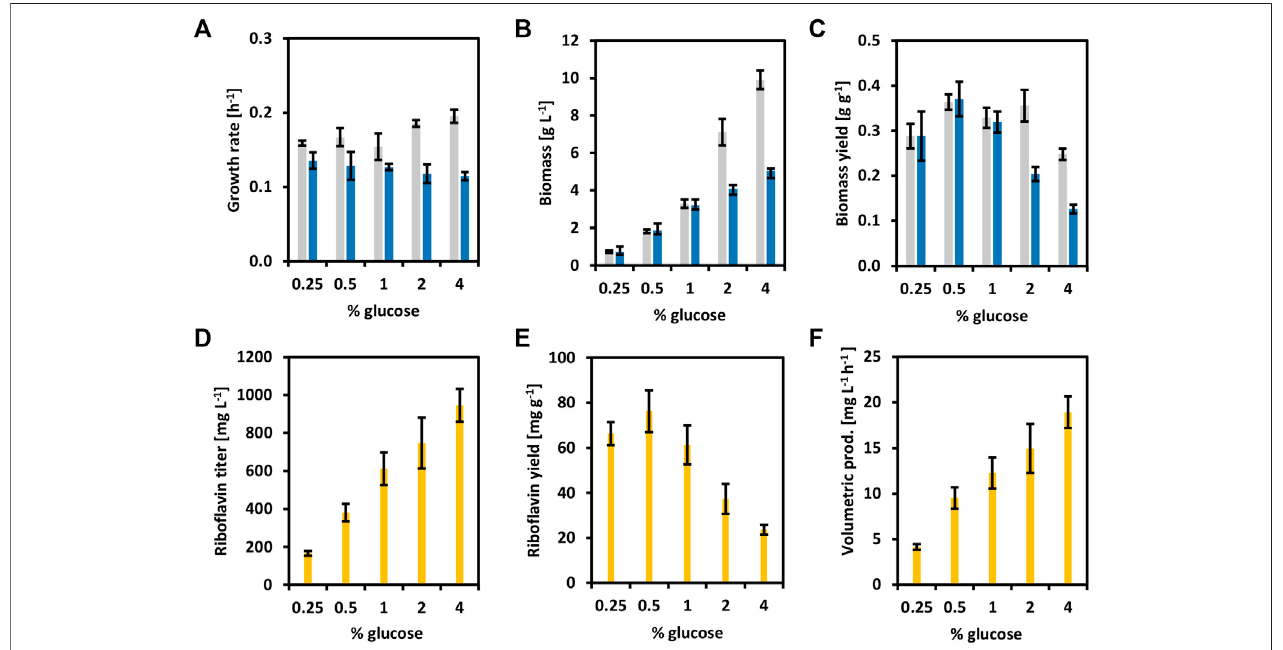
FIGURE 5 | Growth and ribo fl avin production from glucose of the strains CgRibo1 and CgRibo2. Concentrations of glucose ranged from 0.25 to 4 g L − 1 were tested.Growthrates(h − 1 ) (A) , fi nalbiomassesformed(gL − 1 ) (B) ,andbiomassyields(gg − 1 ) (C) ofCgRibo1(grey)andCgRibo2(blue)aredepicted.Production valuesof fi nal ribo fl avin titers (mg L − 1 ) (D) , ribo fl avin yields (mg g − 1 ) (E) , and ribo fl avin volumetric productivities (mg L − 1 h − 1 ) (F) of CgRibo2 are depicted with yellow columns. Means and standard deviations of triplicates are shown.